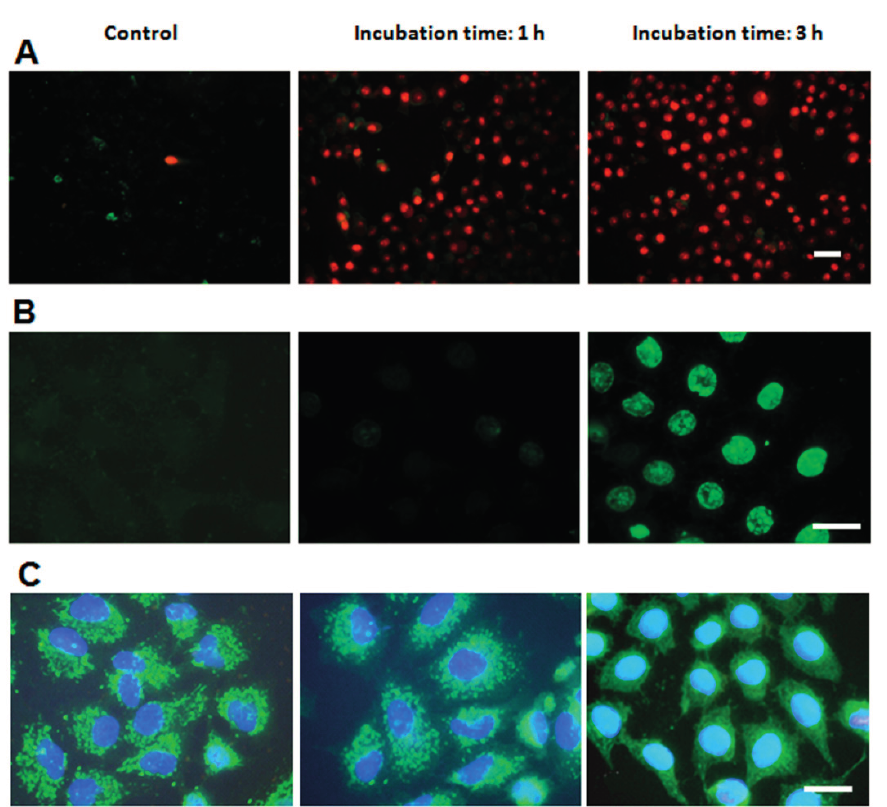
translocation occurred. On the other hand, most nuclei exhibited red PI fluorescence, due to loss of plasma membrane integrity. Figure 3. Assays to characterize the type of cell death performed at different times after photodynamic treatments. ( A ) HeLa cells incubated with 1 µM ZnPc for 1 and 3 h, processed for the Annexin V/propidium iodide (ANV/PI) assays immediately after irradiation and observed in fluorescence microscopy under blue and green excitation light (overlay); ( B ) HeLa cells subjected to the same treatments, processed for TUNEL assay 3 h later and observed in fluorescence microscopy under blue excitation; ( C ) HeLa cells incubated with 1 µM ZnPc (1 and 3 h), processed for indirect immunofluorescence for cyt-c immediately after irradiation, counterstained with H-33258 and observed in fluorescence microscopy under UV and blue excitation light (merged image). Scale bar: 20 µm.